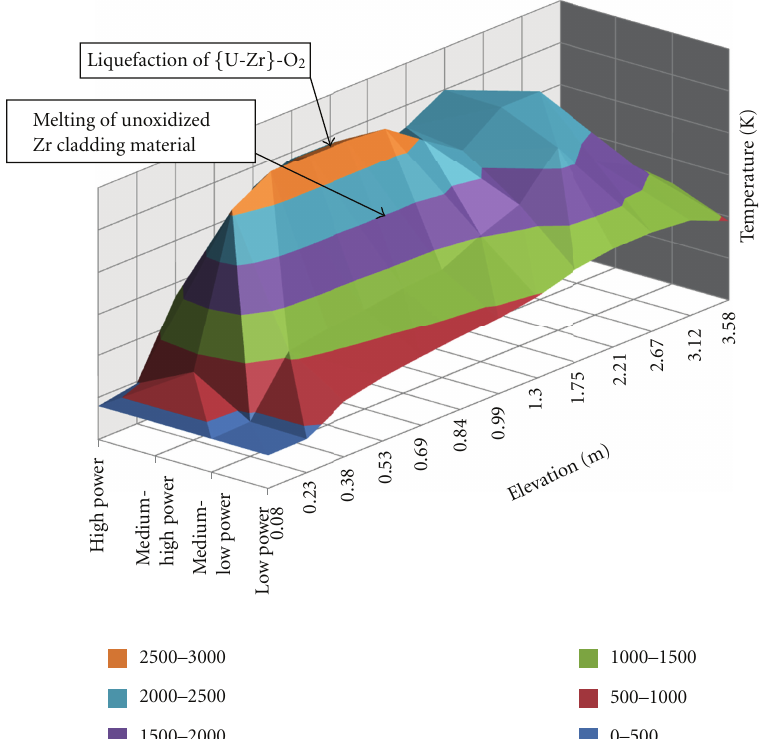
Figure 13: Core temperature distribution at 5.1 hours after reactor scram for a scenario with depressurization and termination of emergency water injection at 4.2 hours after reactor scram (CRD flows